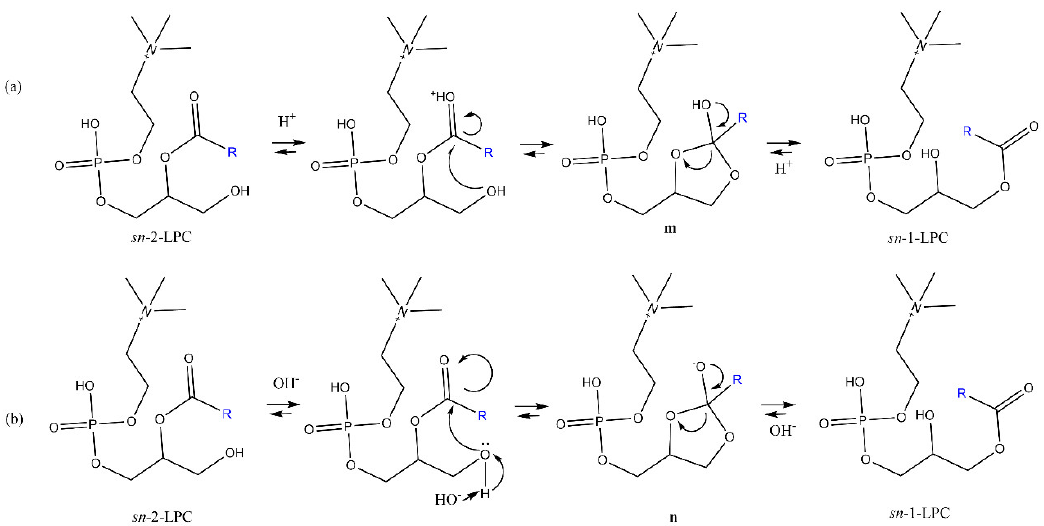
Figure 11. The mechanism of the acyl migration from the sn −2 position to the sn −1 position under acid ( a ) and base ( b ) conditions. In the process of acyl migration, the carbonium ion of fatty acid acyl is attacked by the lone pairs of electrons of the hydroxyl oxygen atom at the sn −1 position and then forms a five−membered ring intermediate ( m and n ). Then the intermediate fractures to form a more stable compound, sn −1−LPC.